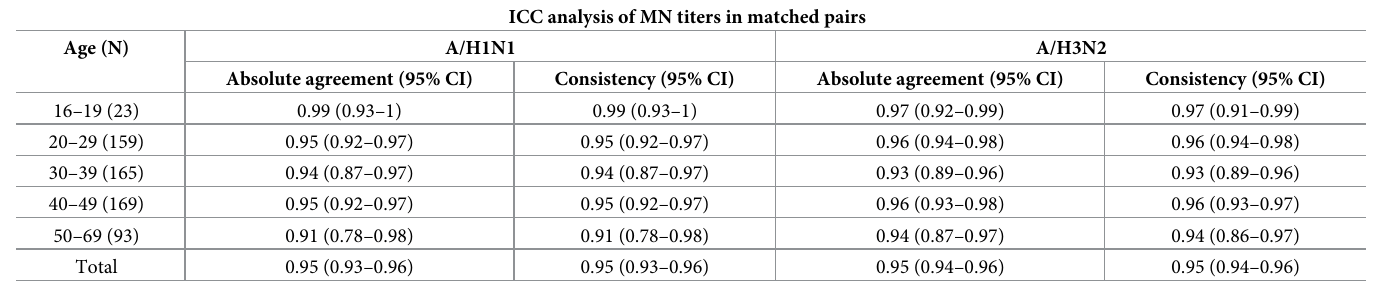
Table 2. ICC values of MN titers in all pairs under the definition of absolute agreement versus